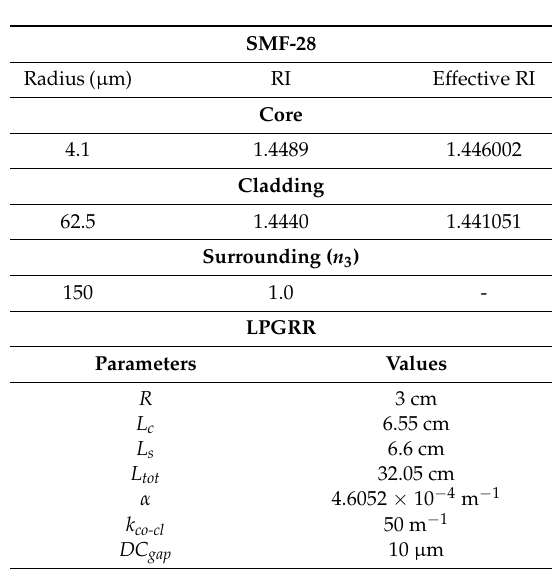
Figure 4. Comparison between theoretical (red curve) and experimental (blue curve) LPG spectral response. Table 1. SMF-28 and LPGRR parameters.